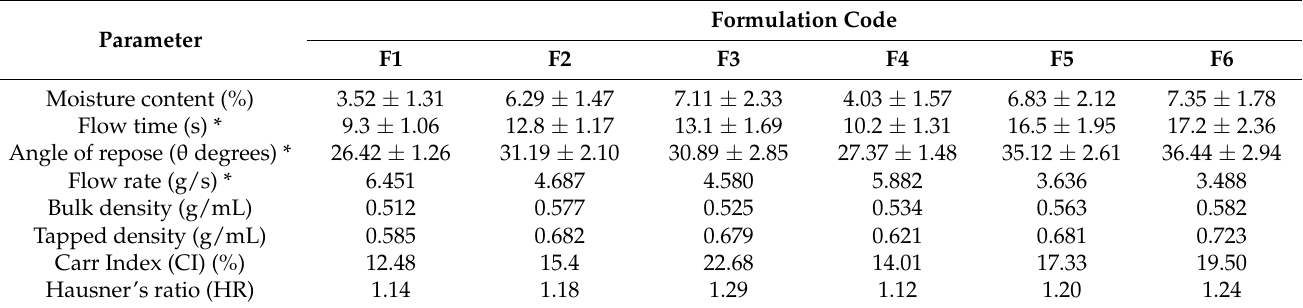
Table 4. Precompression parameters for direct compression